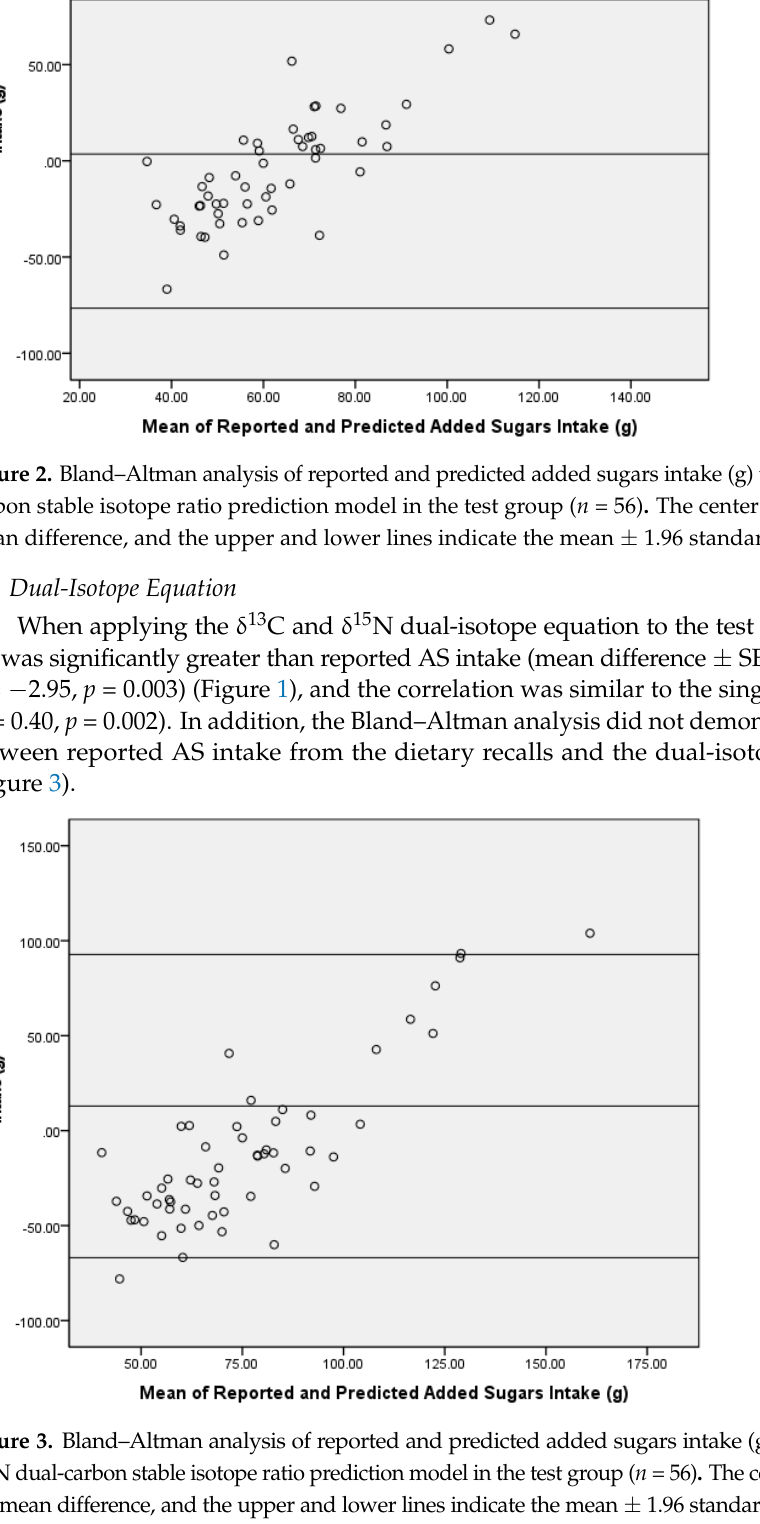
Figure 1. Reported added sugars intake compared to predicted added sugars intake for the δ 13 C single-carbon and δ 13 C and δ 15 N dual-carbon and nitrogen stable isotope ratio prediction models in the test group ( n = 56) . * Significant difference between reported added sugars intake and dual-isotope model at p = 0.02. δ 13 C and δ 15 N dual-isotope model (mean differ- ence ± standard error = 13.0 ± 5.4 g; Z = − 2.95; p = 0.003). No significant difference was found between reported added